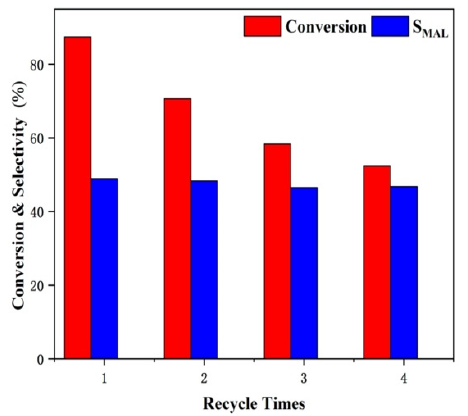
Figure 9. Reusability test results for Mg 3 Al–Pro-LDHs.